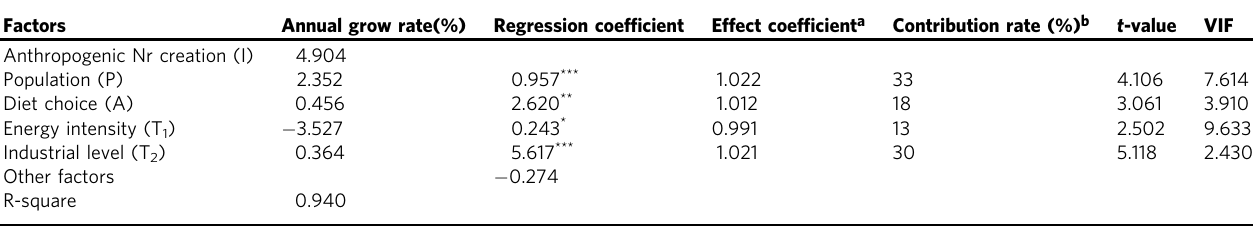
Table 2 Contributions of socioeconomic factors to changes in anthropogenic Nr creation.